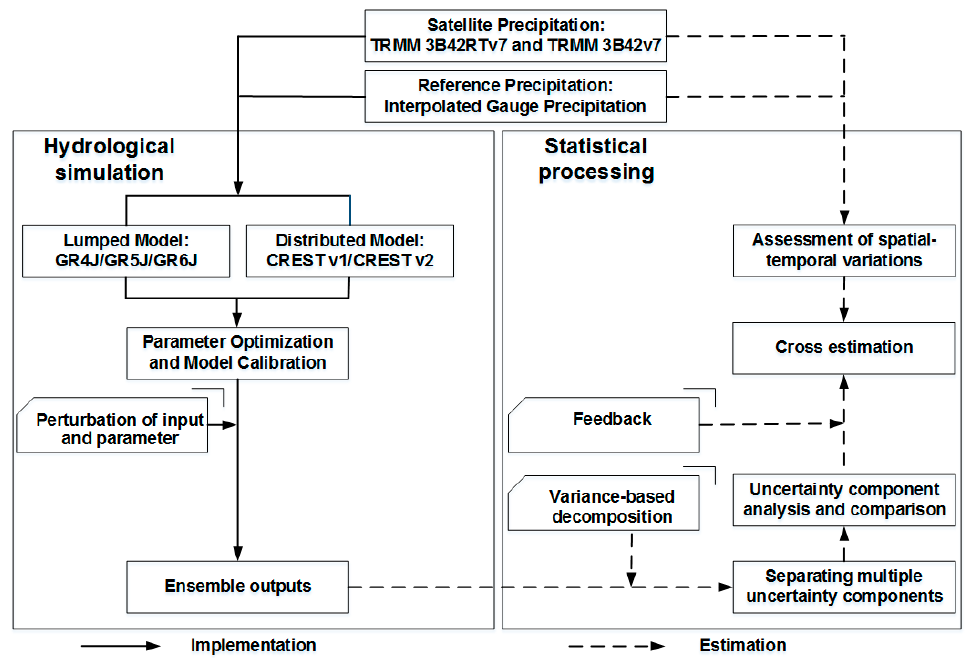
Figure 2. Overall framework of assessing the satellite precipitation estimate and quantifying its input uncertainty in driving hydrological models using the variance decomposition method.